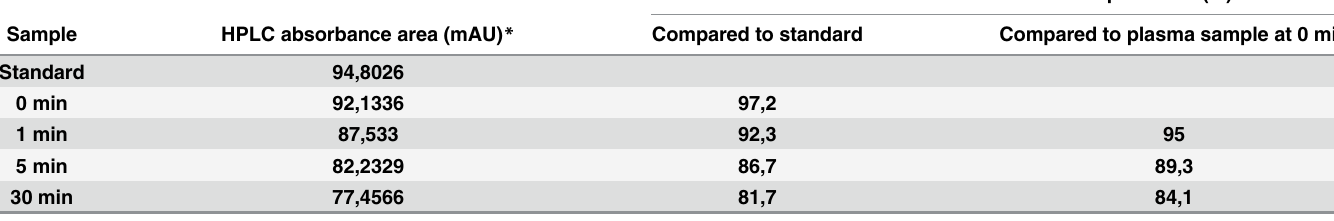
Table 1. Plasma stability.